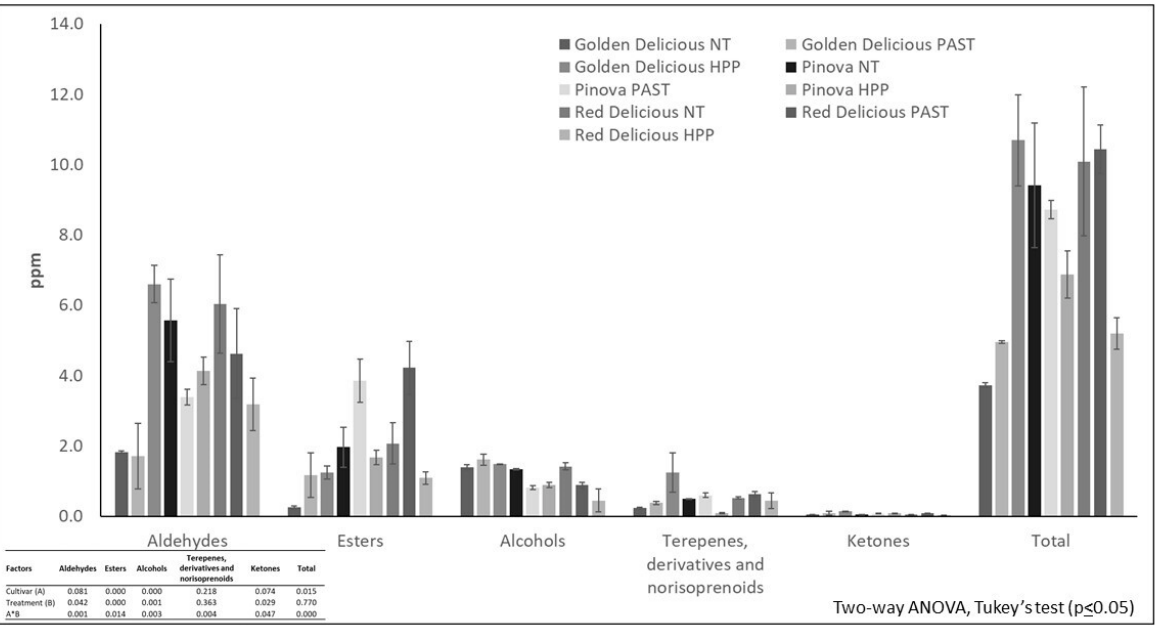
Figure 3. Volatile composition and amount of juices pertaining to three apple cultivars and different processes.